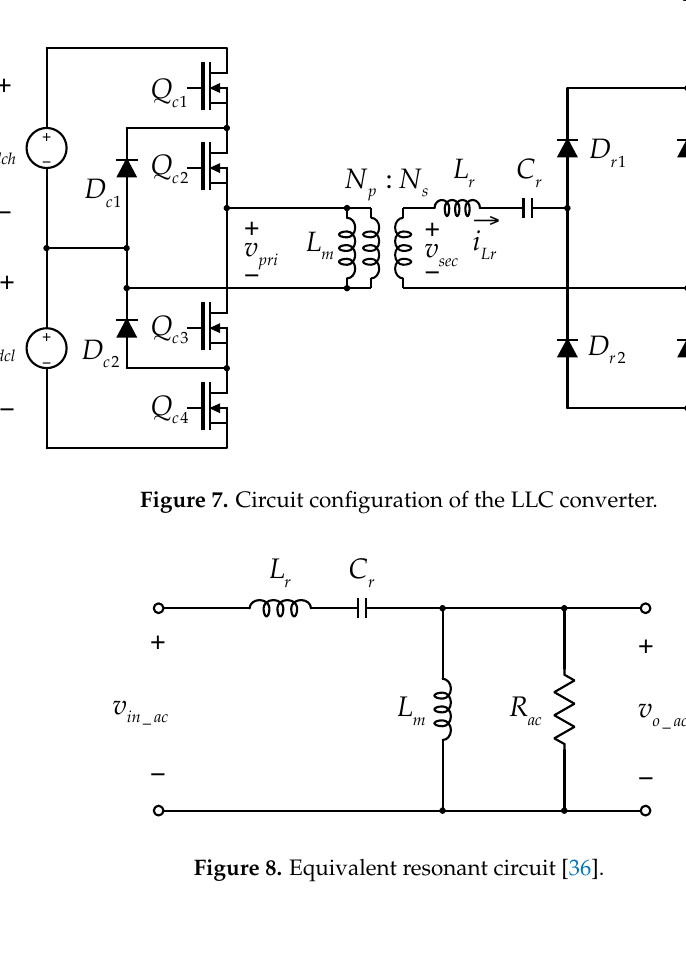
Figure 6. Modulation schemes for the PFC converter. ( a ) Original modulator; ( b ) Equivalent structure of the original modulator.